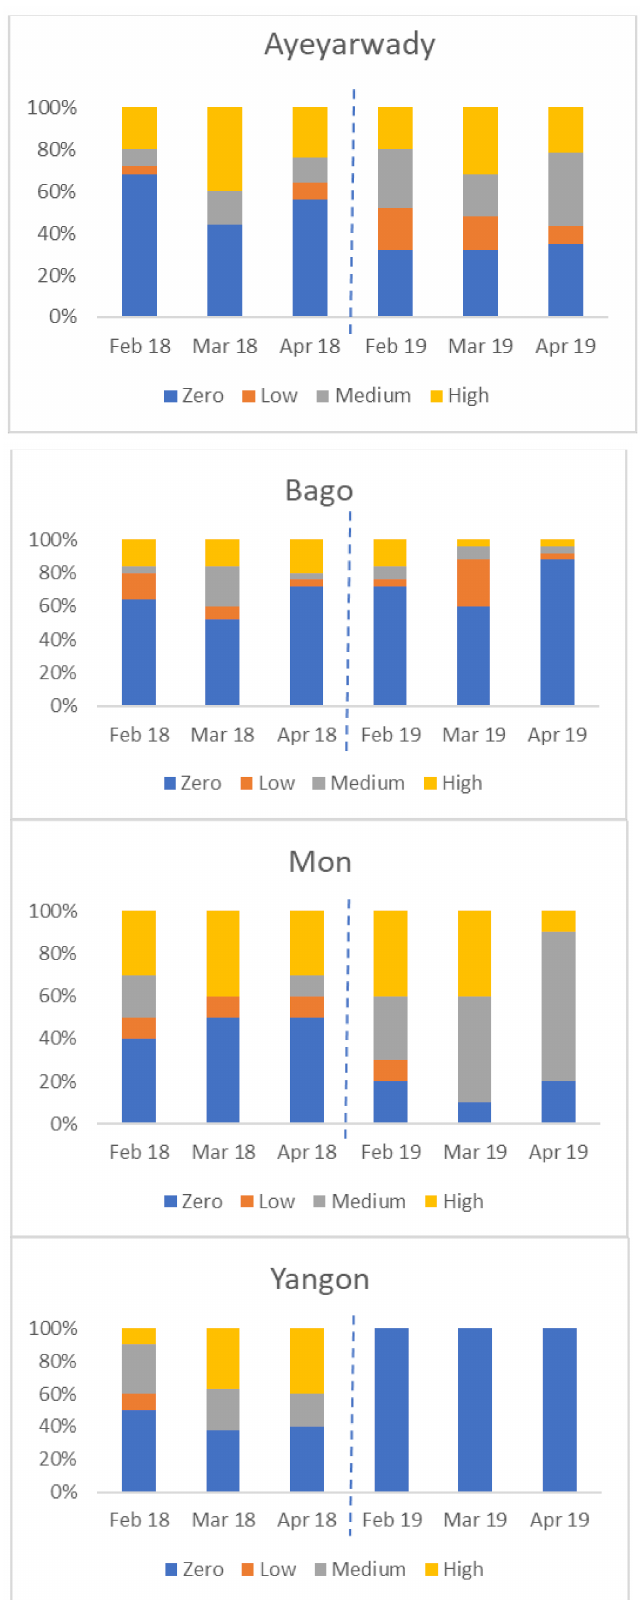
Figure 6. Variation in percentage of flocks by serological category (Y axis) in four States/Regions, from February to April 2018 and 2019 (zero seroconversion, low seroconversion, medium seroconversion, and high seroconversion—see Materials and Methods for